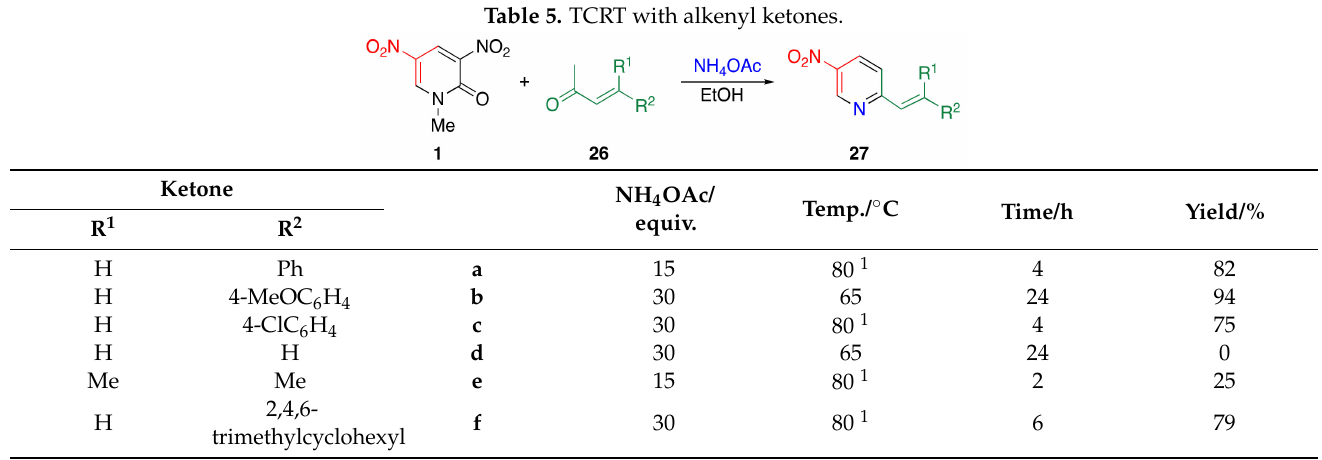
Table 5. TCRT with alkenyl